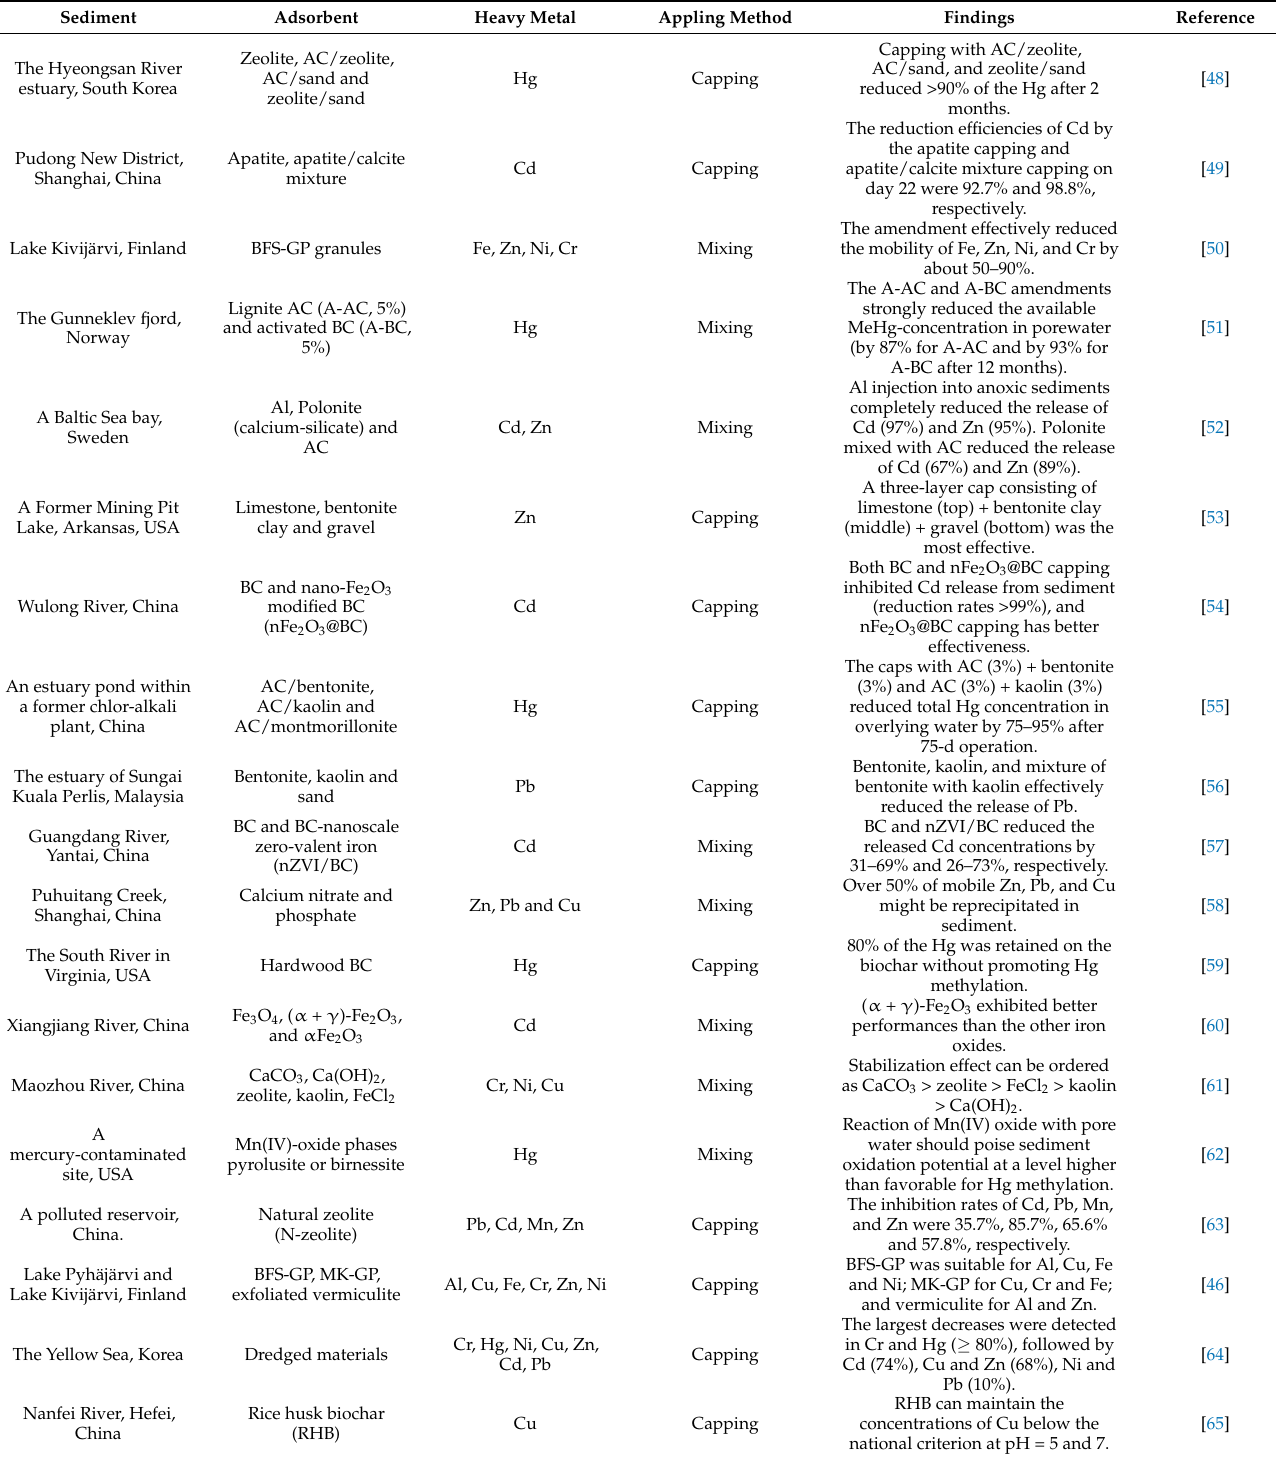
Table 1. Studies of in situ active capping and chemical amendments for heavy metal contaminated sediment in recent